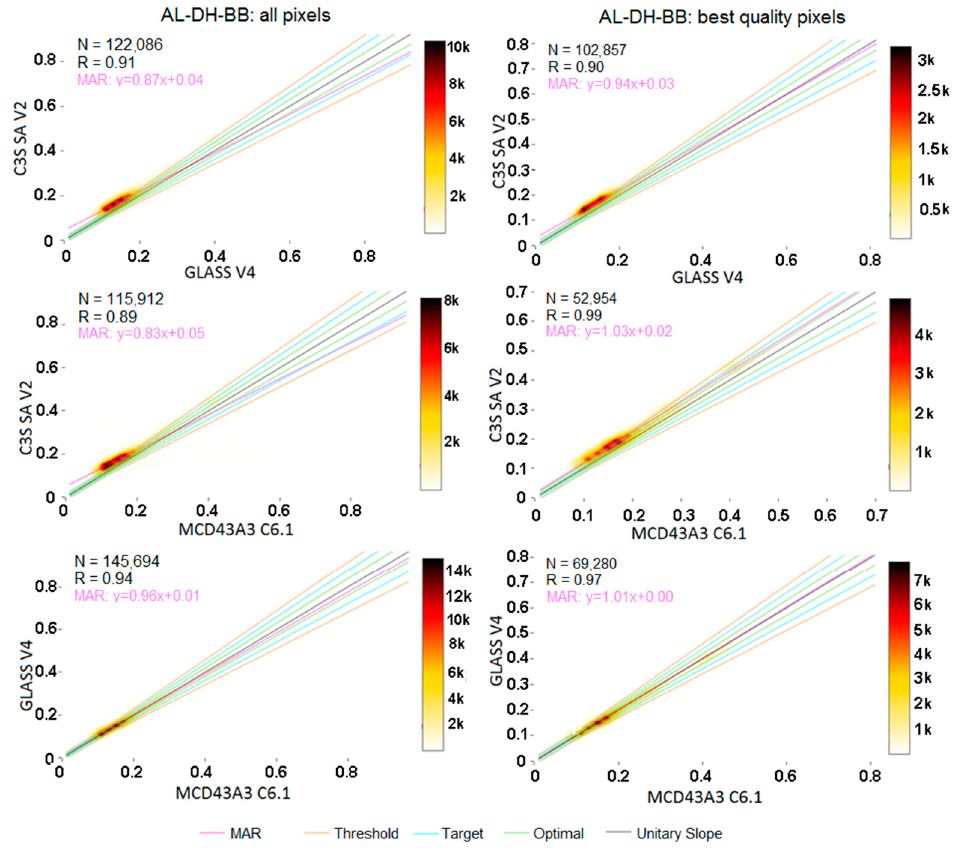
Figure 12. Scatterplots of C3S V2 vs. GLASS V4 ( top ), C3S V2 vs. MCD43A3 C6.1 ( middle ), and GLASS V4 vs. MCD43A3 C6.1 ( bottom ) for all pixels ( left ) and best quality pixels ( right ) for black-sky total shortwave retrievals in the 2001–2005 period over LANDVAL sites. Table 10. Summary of the main statistics for scatterplots between C3S V2 vs. GLASS V4, C3S V2 vs. MCD43A3 C6.1, and GLASS V4 vs. MCD43A3 C6.1 for black-sky total shortwave retrievals in the 2001–2005 period over LANDVAL sites. All quality pixels are taken into account.